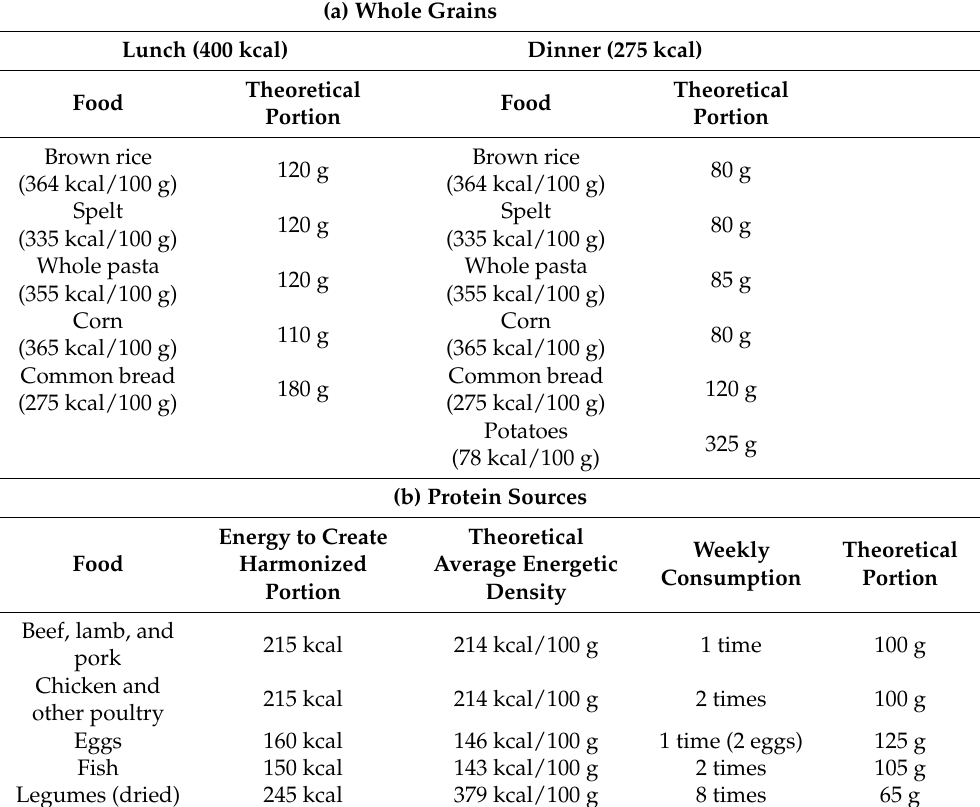
Table 2. Reference scheme for